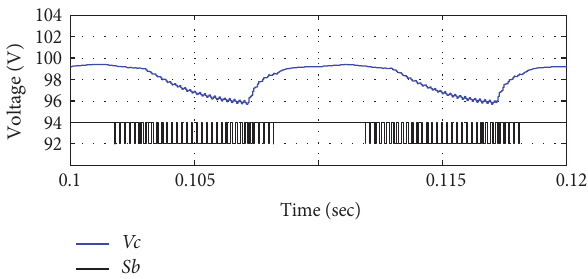
Figure 13: Voltage across the capacitor during the turning ON/OFF of switch 𝑆 𝑏 .